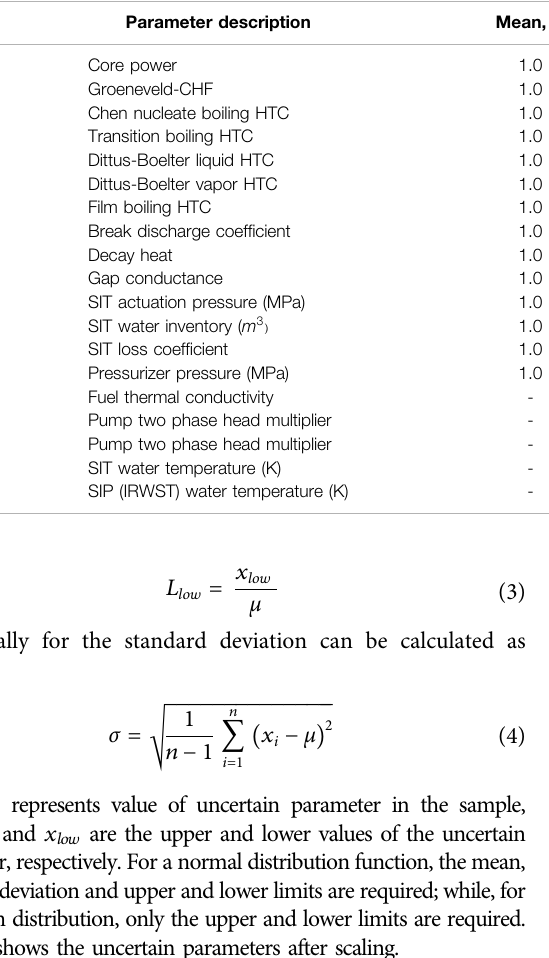
a uniform distribution, only the upper and lower limits are required.